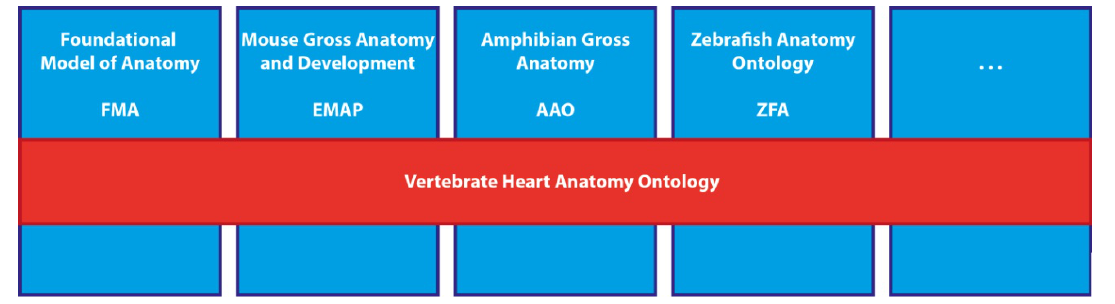
Figure 1: Illustration of the vertical approach, adopted by most anatomy ontologies in the OBO Foundry, and the horizontal approach presented